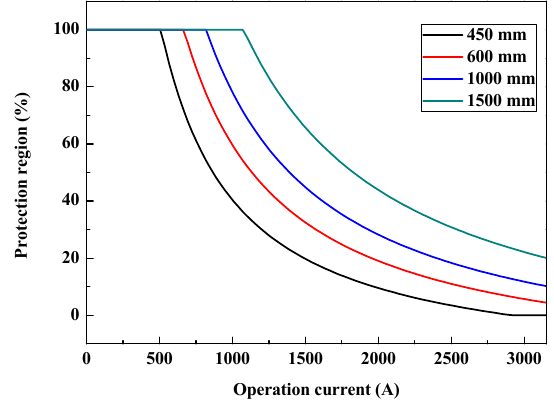
Figure 16. Influence of operation current on protection region of arcing horns. Table 5. Influence of operation current on protection region of arcing horns.